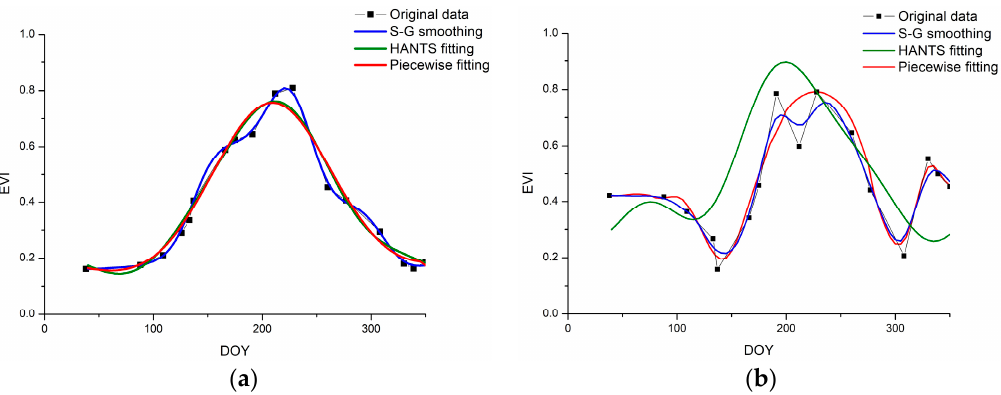
Figure 14. Comparisons between the Savitzky-Golay Filter (S-G) smoothing method, the HANTS fitting method and our piecewise fitting method. ( a ) The EVI time profile of single season rice farmland; ( b ) The EVI time profile of a “cole-paddy rice-cole” rotated farmland.